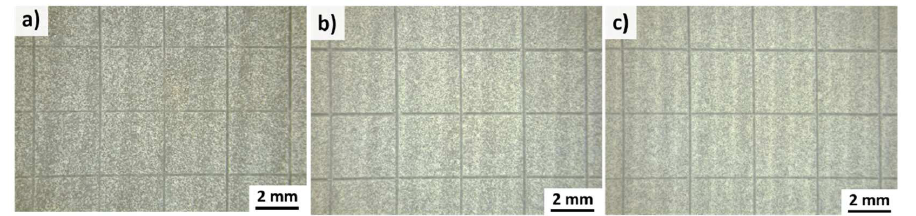
Figure 9. Microscopic images after the cross-cutting tests. PA12 coatings deposited by a constant energy density of 2.1 J/mm 2 and different powder mass flows of ( a ) 0.2 g/min, ( b ) 0.6 g/min and ( c ) 1.4 g/min.